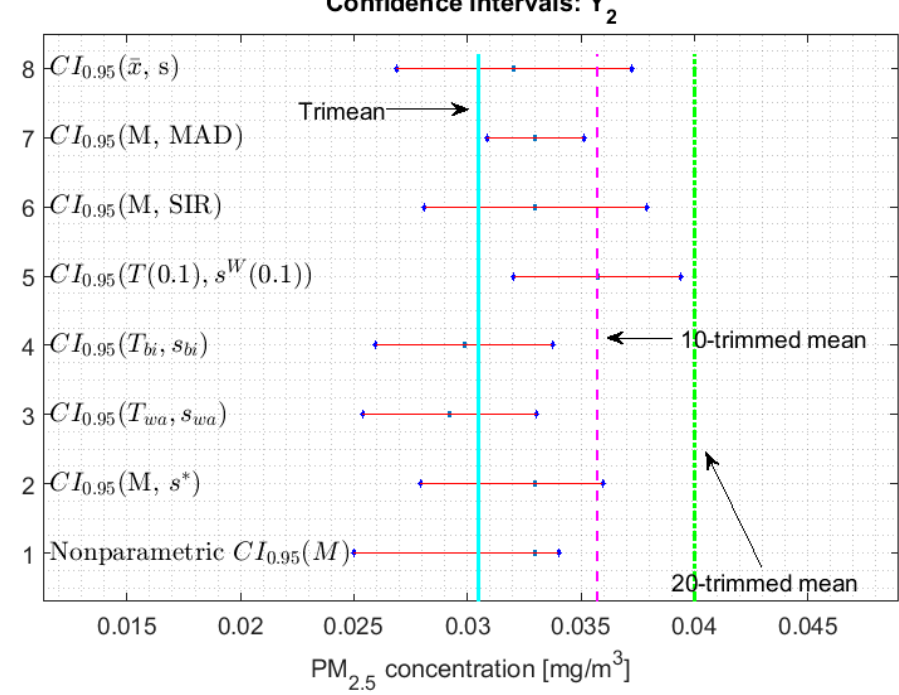
Sensors 2020 , 20 , 654 Figure 6. 95% confidence intervals (𝐶𝐼 (cid:2868).(cid:2877)(cid:2873) ) for robust and non-robust estimators: 𝑌 (cid:2870) . Figure 6. 95% confidence intervals ( CI 0.95 ) for robust and non-robust estimators: Y 2 .